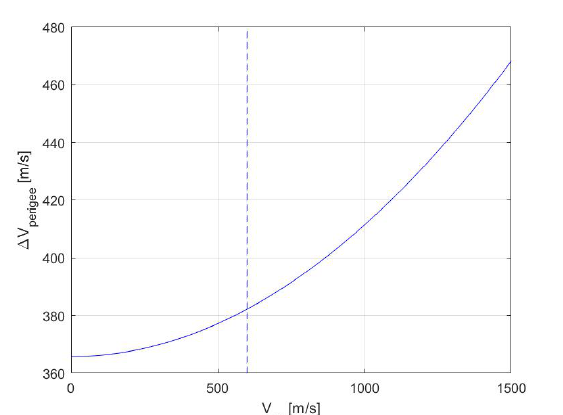
Figure 3. Required ∆ V at the SSGTO perigee in function of the hyperbolic excess velocity (solid line), and 600 m/s threshold escape velocity (dashed